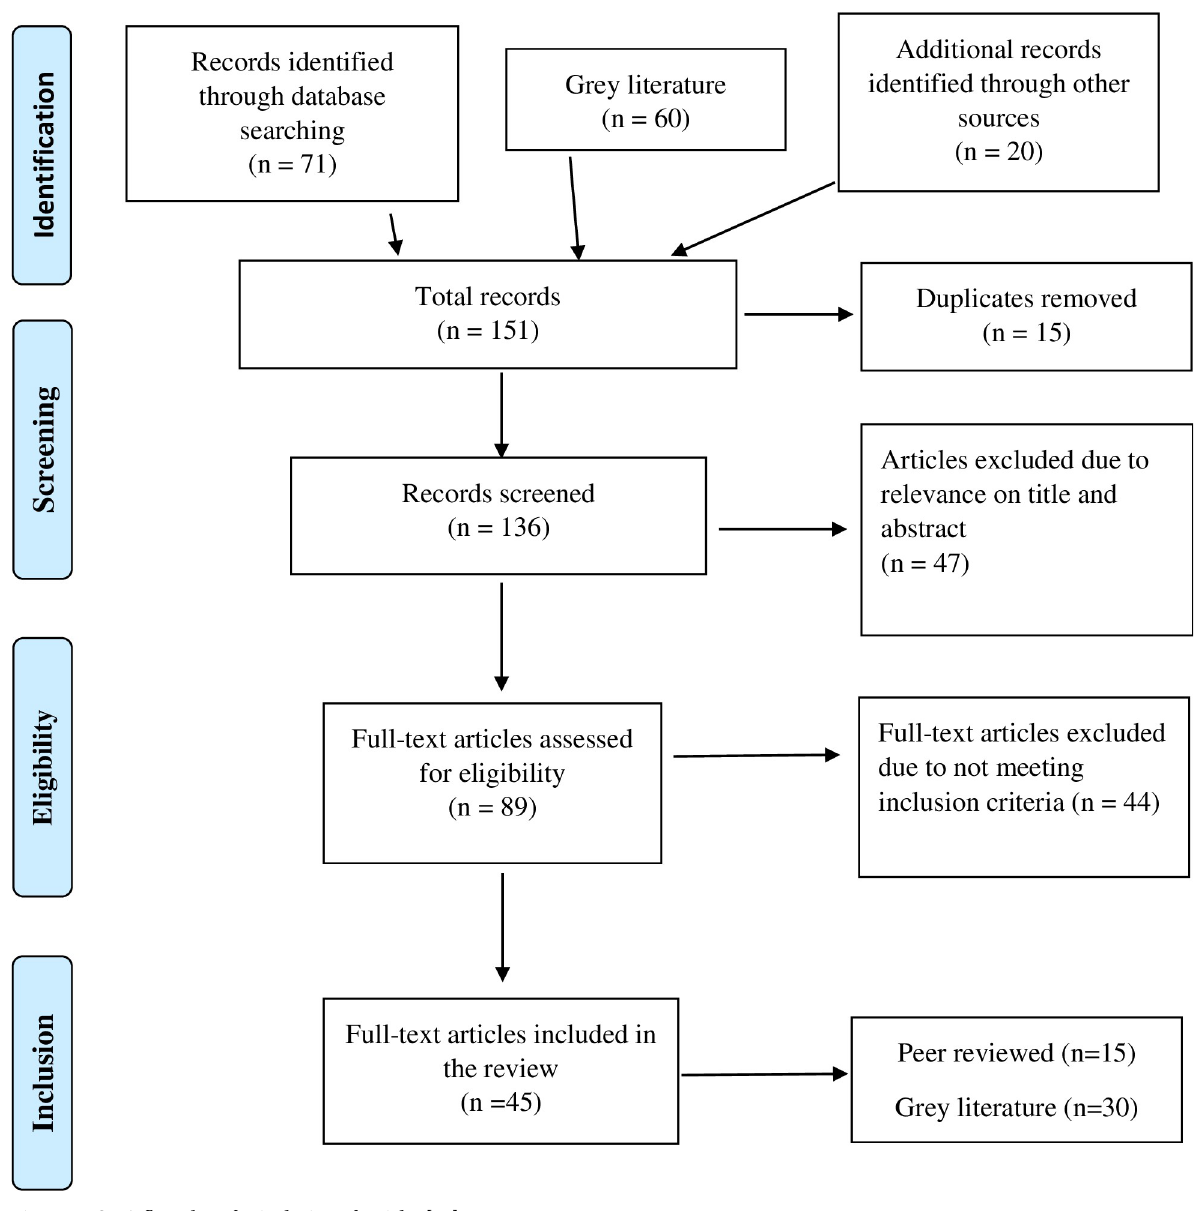
Fig 1. PRISMA flow chart for inclusion of articles